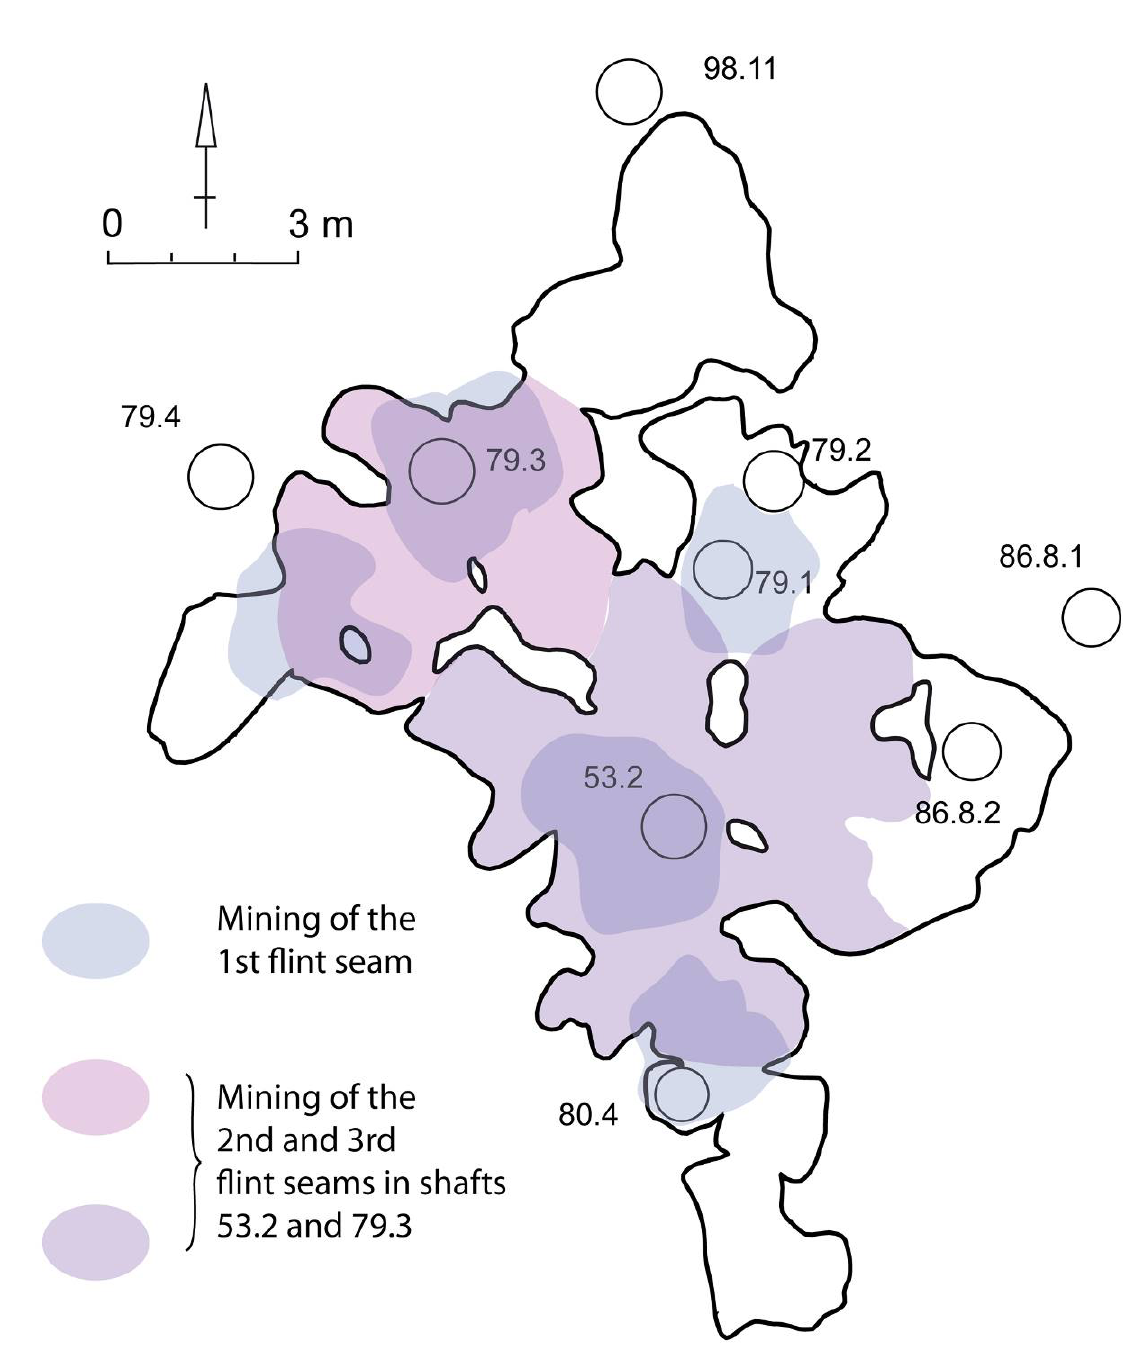
Figure 16. Petit-Spiennes. Underground map of the mines excavated by the SRPH from 1953 to 2003. Graphics by M. Woodbury, SPW after Ladouce (2002) and Gosselin